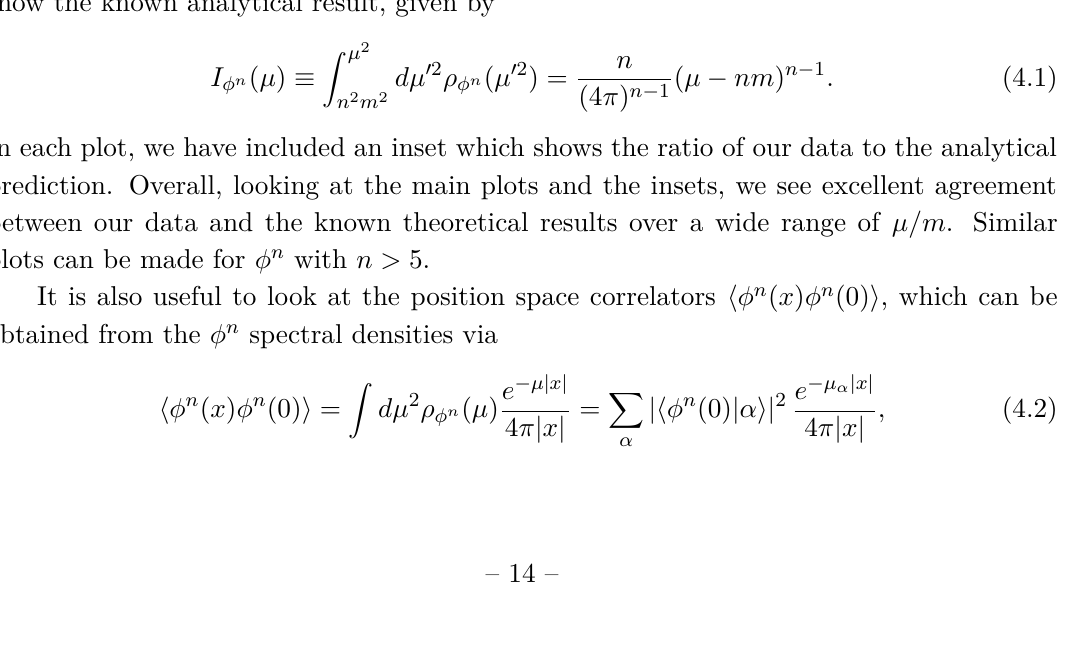
= 1411 ), along with the m